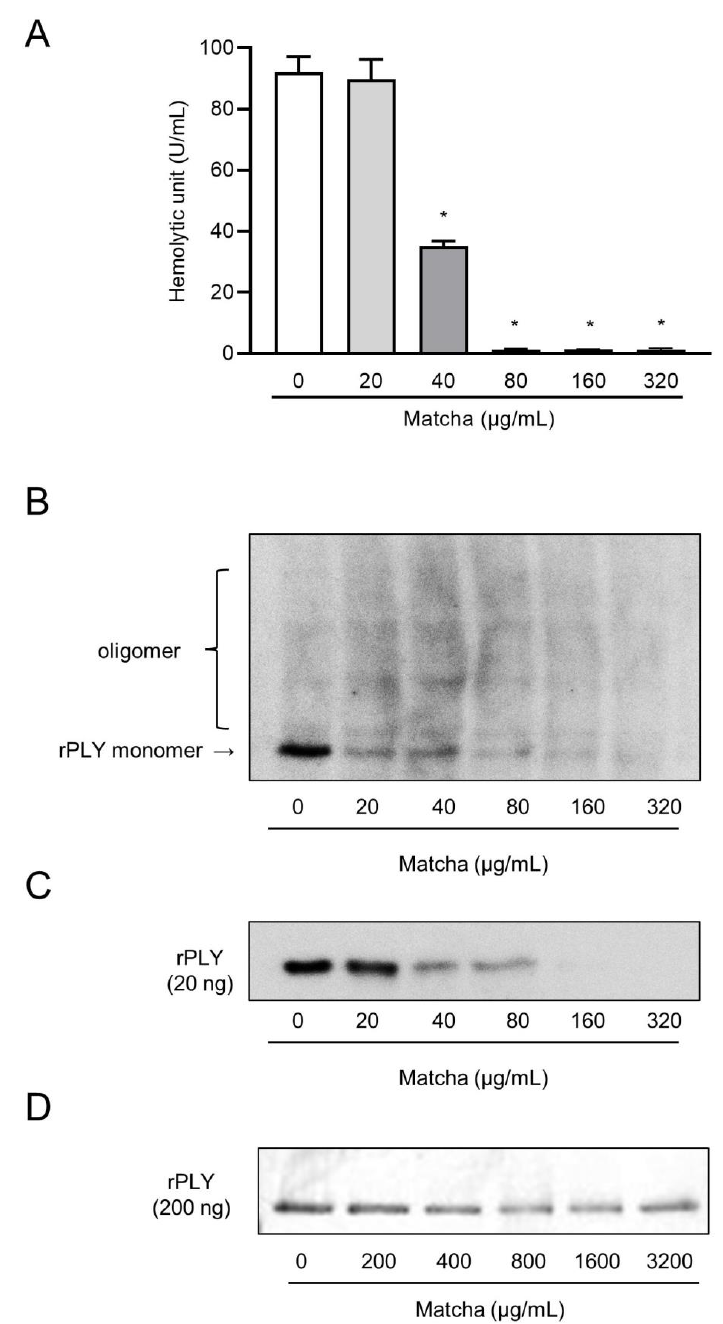
Figure 2. Matcha supernatants decrease PLY-induced hemolysis. Recombinant PLY (rPLY; 1 μg/mL) was preincubated with varying concentrations of matcha supernatant at 37 °C for 1 h. ( A ) The hemolytic activity in each sample was determined. Data are shown as the mean ± SD ( n = 3 per group) and were evaluated using one-way analysis of Dunnett’s multiple-comparisons test; * p < 0.05 versus the untreated group. ( B ) PLY oligomerization of the samples was detected by western blotting using the anti-PLY antibody clone PLY-4. The experiment was repeated three times, and a representative result is shown. rPLY was co-incubated with the matcha supernatant at 37 ◦ C for 1 h, and the PLY of the samples was detected ( C ) by western blotting and ( D ) Coomassie Brilliant Blue